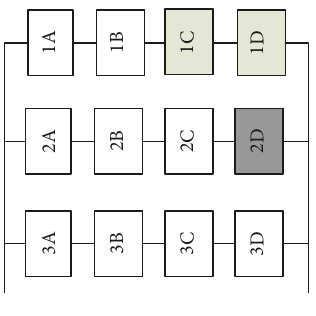
Figure 9: Configuration of PV array.